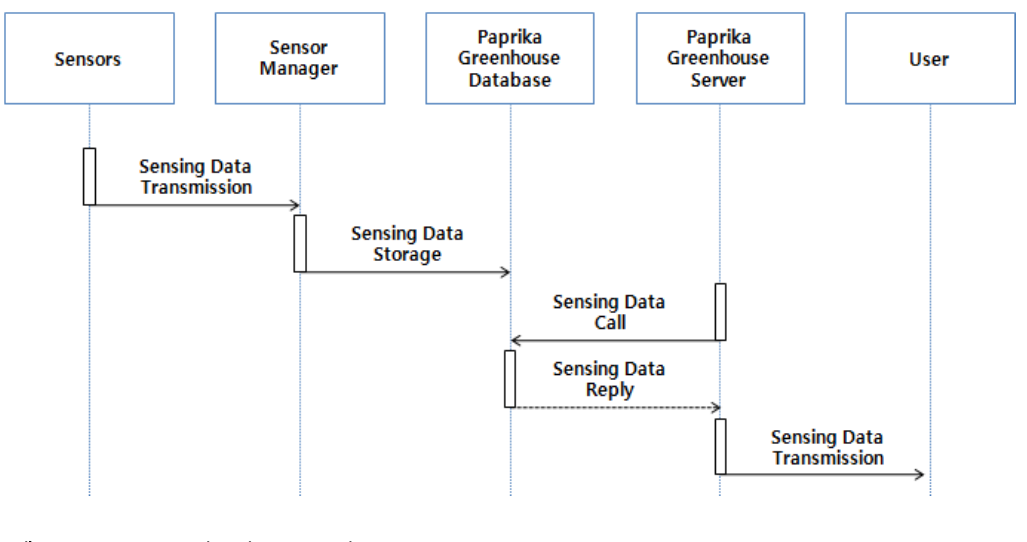
Figure 2. Paprika Environment & Growth Information Monitoring Operations.